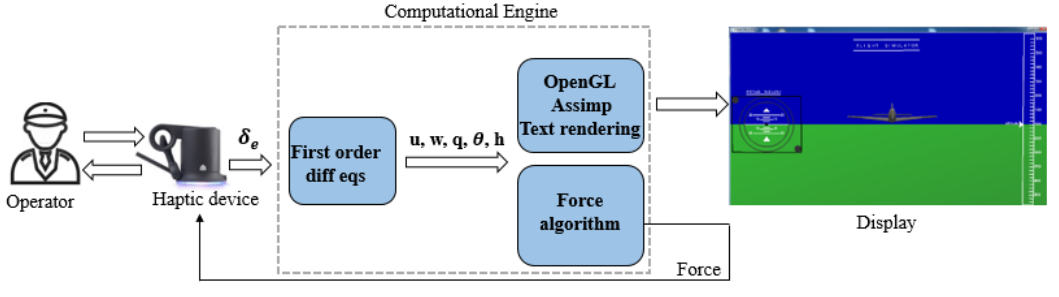
Figure 5. System